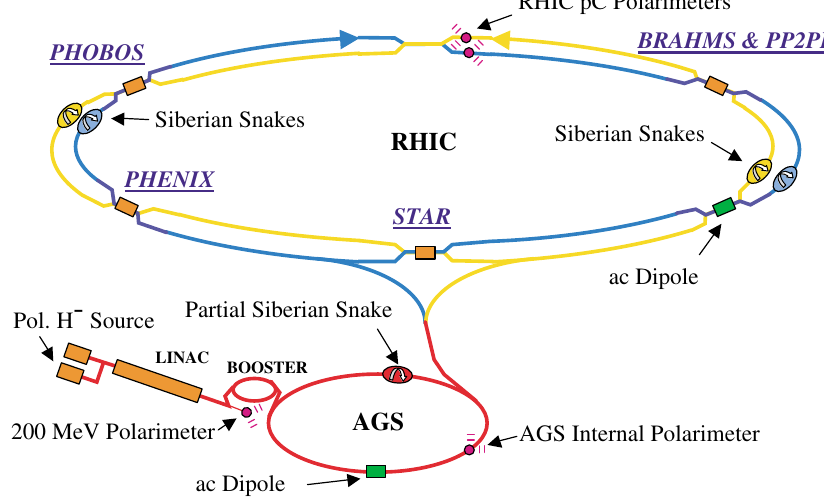
FIG. 1. (Color) The AGS-RHIC complex